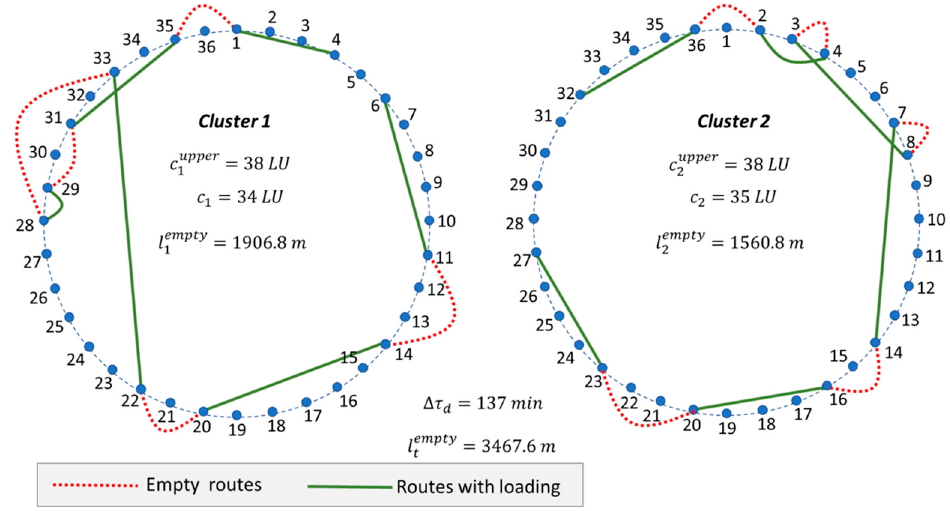
Figure 12. Clustered and sequenced supply-demands in scenario 1.